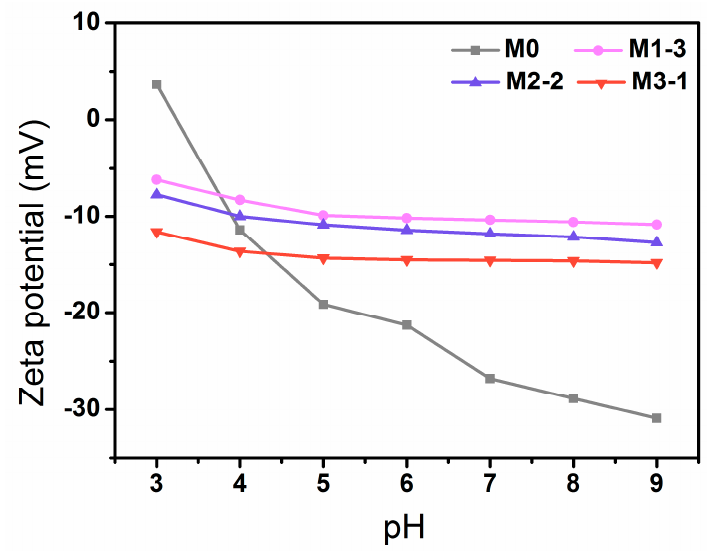
Membranes 2021 , 11 , x FOR PEER REVIEW Figure 6. Zeta potential of original membrane and modified membranes. Figure 6. Zeta potential of original membrane and modified membranes.